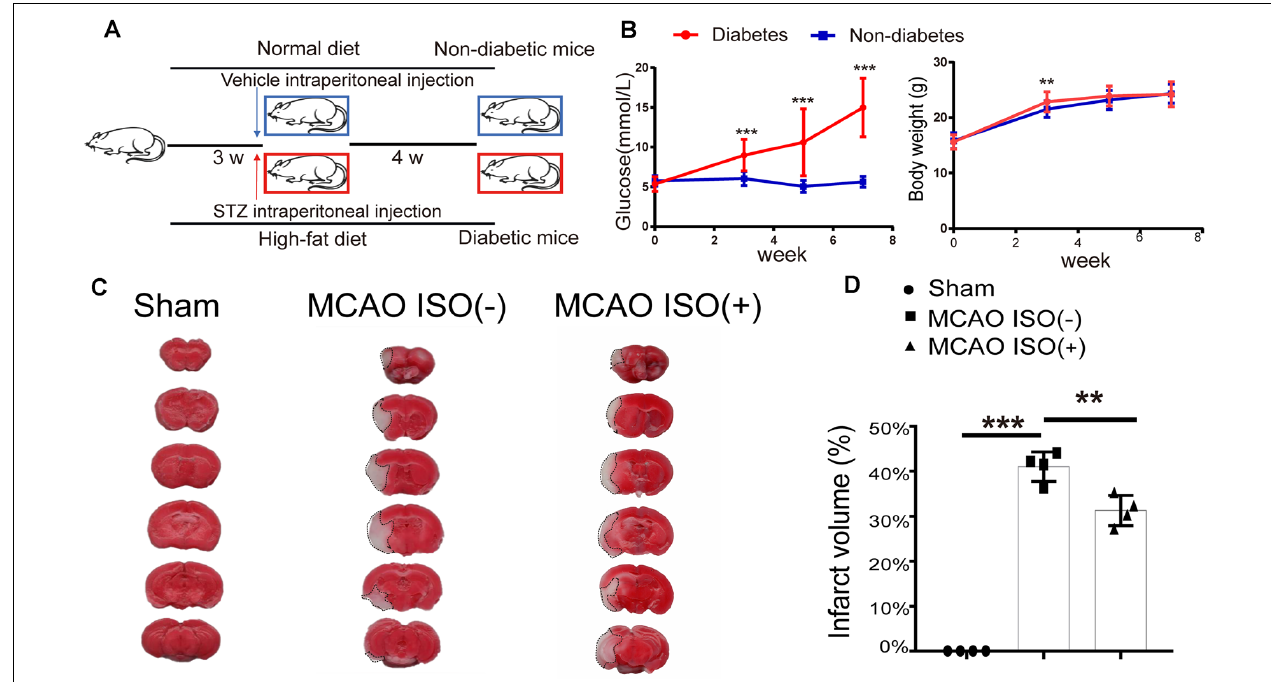
FIGURE 1 | Isoflurane (ISO) pretreatment protects the brain against ischemic damage in a diabetic mouse model. (A) Diagram of the protocol used to generate the type 2 diabetic mouse model. (B) Continuous monitoring of the blood glucose and body weight changes from the beginning of the high-fat diet (0 week) in diabetic mice and non-diabetic mice. n = 24 in each group. (C) Representative images of TTC-stained coronal brain slices of sham-operated (left), middle cerebral artery occlusion (MCAO) mice without ISO pretreatment (middle) and MCAO mice with ISO pretreatment (right). The infarct area is indicated via the dotted line. (D) The infarct volume in the sham-operated, MCAO mice without ISO pretreatment, and MCAO with ISO pretreatment. n = 4 in each group. ** P < 0. 01, *** P < 0.001.